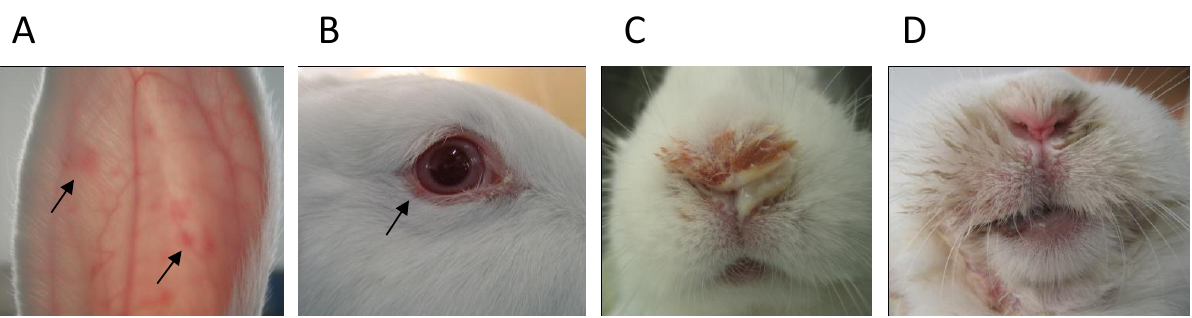
Figure 7. Presentation of disease in rabbits infected by aerosol transmitted RPV. Rabbits were infected as described in Figure 5. (A) Secondary lesions observed in the ears of animals exposed to RPV via aerosol. Arrows show locations of 2 representative lesions in the ear. (B) Photograph of a secondary lesion on the eye of an animal marked with arrow. (C) Normal profile of intradermally lethally infected RPV rabbit nose. (D) Profile of aerosol infected RPV rabbit showing severe swelling of nose and muzzle. Reproduced with permission from American Society for Microbiology [12].